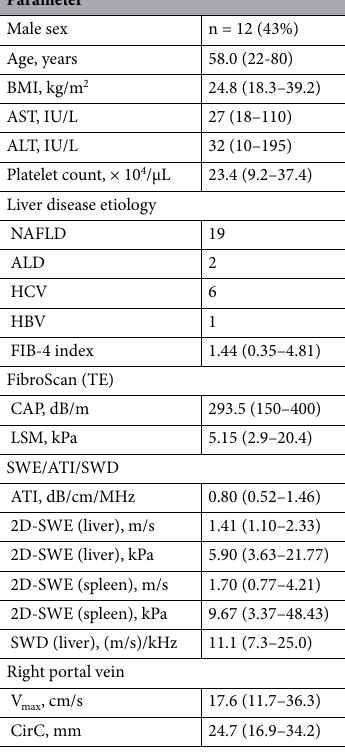
Table 1. Patients characteristics ( n = 28). Conversion to liver stiffness obtained by 2D-SWE is calculated by E (kPa) = ρV 2 and displayed. ρ is the density and v is the speed of the shear wave (m/s). Data are shown as n (%) or median and range. BMI body mass index, AST aspartate aminotransferase, ALT alanine aminotransferase, AST aspartate aminotransferase, ALD alcoholic liver disease, HCV hepatitis C virus, HBV hepatitis B virus, FIB-4 Fibrosis-4, TE transient elastography, CAP controlled attenuation parameter, LSM liver stiffness measurement, SWE Shear wave elastography, ATI Attenuation imaging, 2D Two-dimensional, SWD Shear wave dispersion, CirC